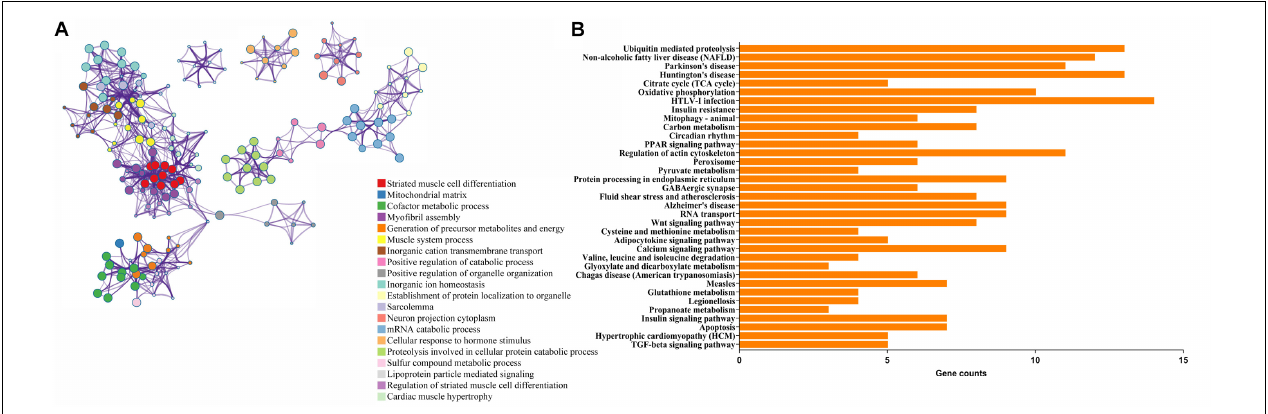
FIGURE 1 | Functional enrichment analyses of differentially expressed genes (DEmRNAs). (A) Enriched ontology clusters. Each term is represented by a circle node, where its size is proportional to the number of input genes falling into that term, and its color represents its cluster identity (i.e., nodes of the same color belong to the same cluster). Terms with a similarity score > 0.3 are linked by an edge (the thickness of the edge represents the similarity score). (B) The top 20 KEGG enrichment analysis for DEmRNAs. The numbers on the x -axis are the names of pathways. The numbers on the y -axis are gene counts.